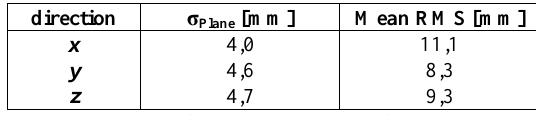
Table 1. Results of the alignment to a reference data set.